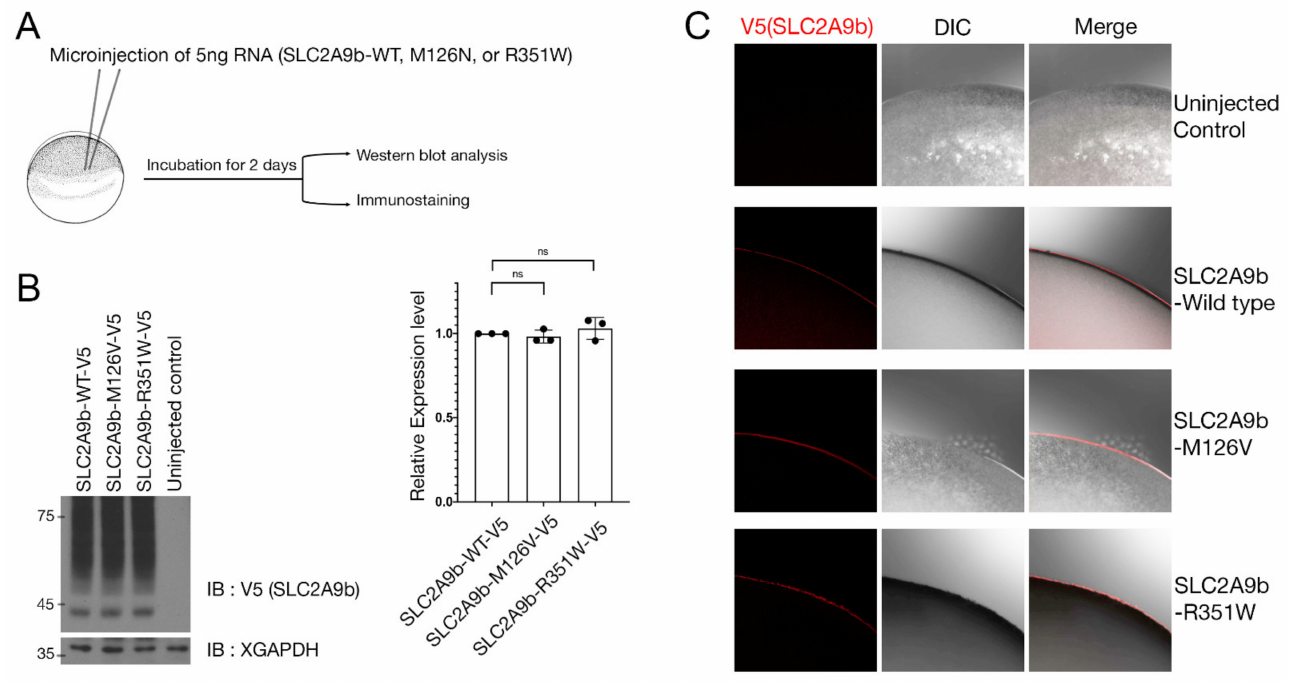
Figure 4. Expression of WT and mutant SLC2A9b in Xenopus oocytes. ( A ) Schematic representation of the experimental procedure. The same amount of wild-type or mutants SLC2A9b RNAs were injected into oocytes. The oocytes were harvested after 2 days and then, Western blot analysis or immunostaining was performed. ( B ) SLC2A9b wild type and mutants showed similar protein expression levels. The histogram depicts the relative protein expression level ( n = 3). Quantification with one-way ANOVA (Dunnett’s multiple comparisons test), p = 0.4363. Data represent the mean ± S.D. of three individual experiments. ns : no statistical differences between the groups. ( C ) Immunostaining was performed using anti-V5 antibodies. Both WT and mutants SLC2A9b showed plasma membrane localization in Xenopus oocytes. DIC; differential interference contrast